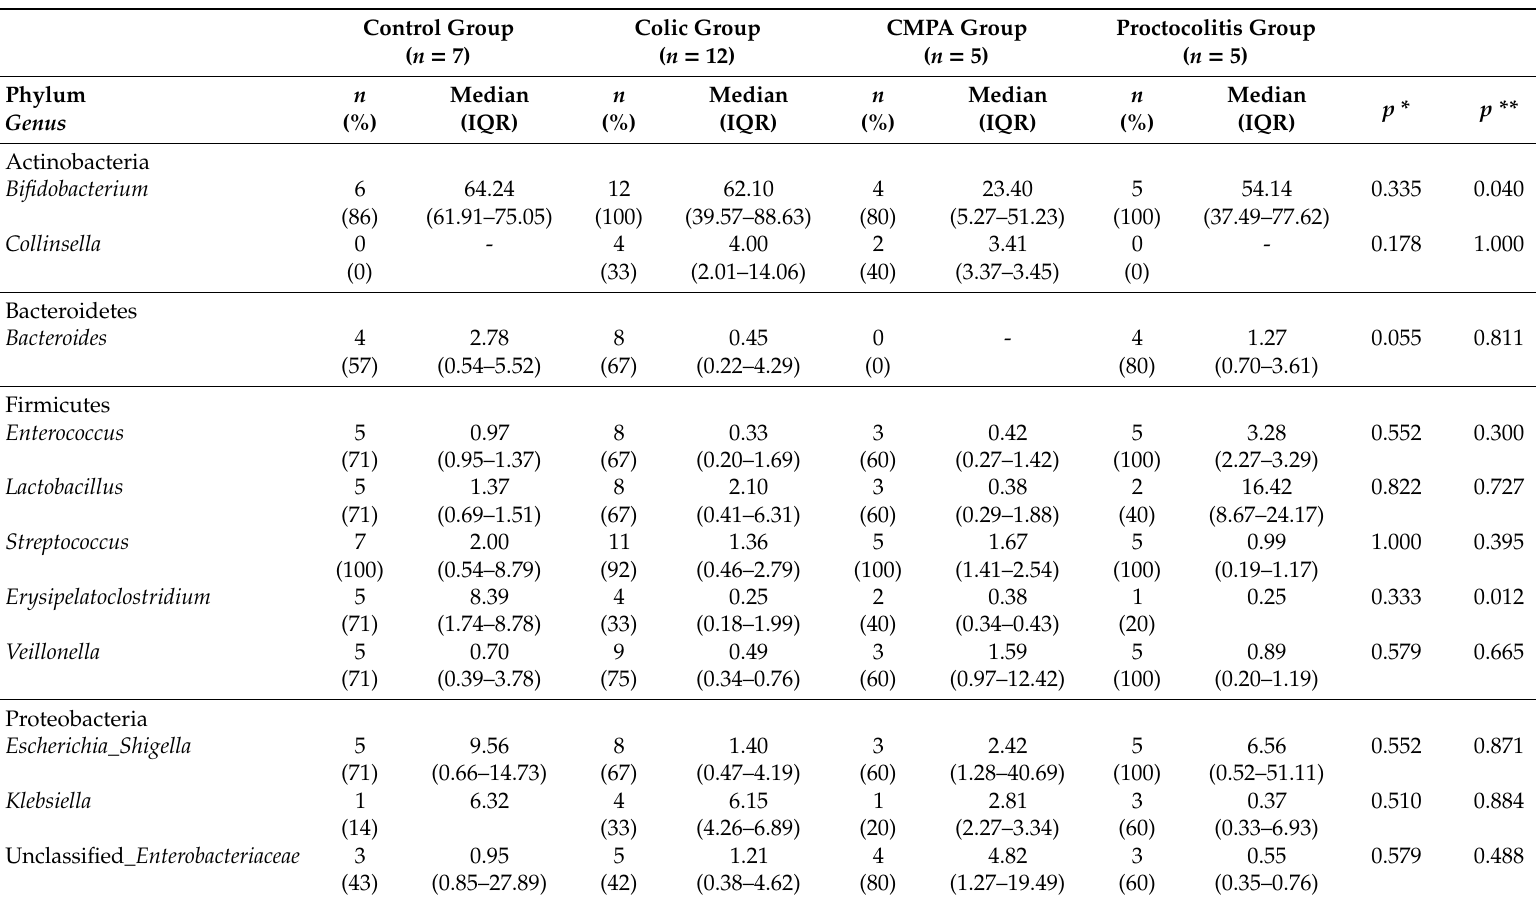
Table 2. Frequency and relative abundance of operational taxonomic units at genus level in fecal samples from participants ( N = 29) in each group of study: control, colic, cow’s milk protein allergy (CMPA), and